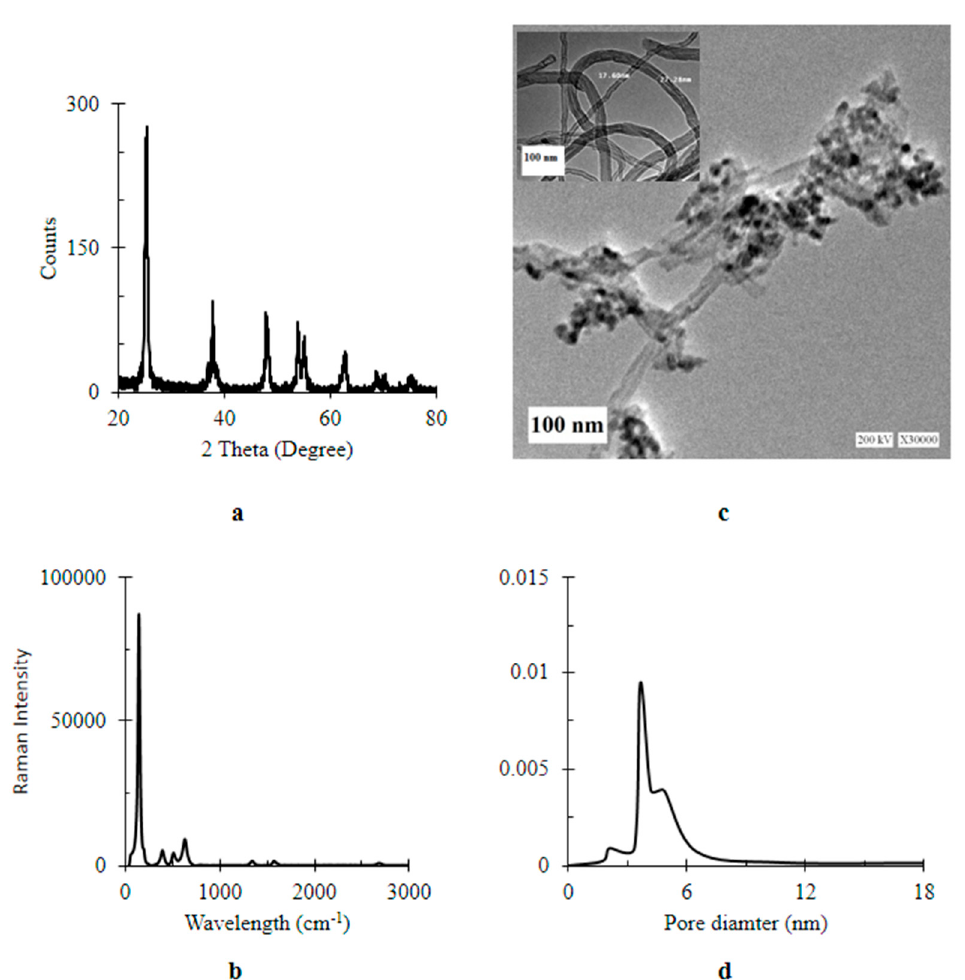
Figure 1. Characterization of titanium dioxide-decorated multi-walled carbon nanotubes (MWCNTs/TiO 2 ) ( a ) XRD (X-Ray Diffraction) pattern; ( b ) Raman spectrum; ( c ) TEM (Transmission Electron Microscopy) image at a magnification bar of 100 nm (inset bare MCNTs); ( d ) pore diameter.